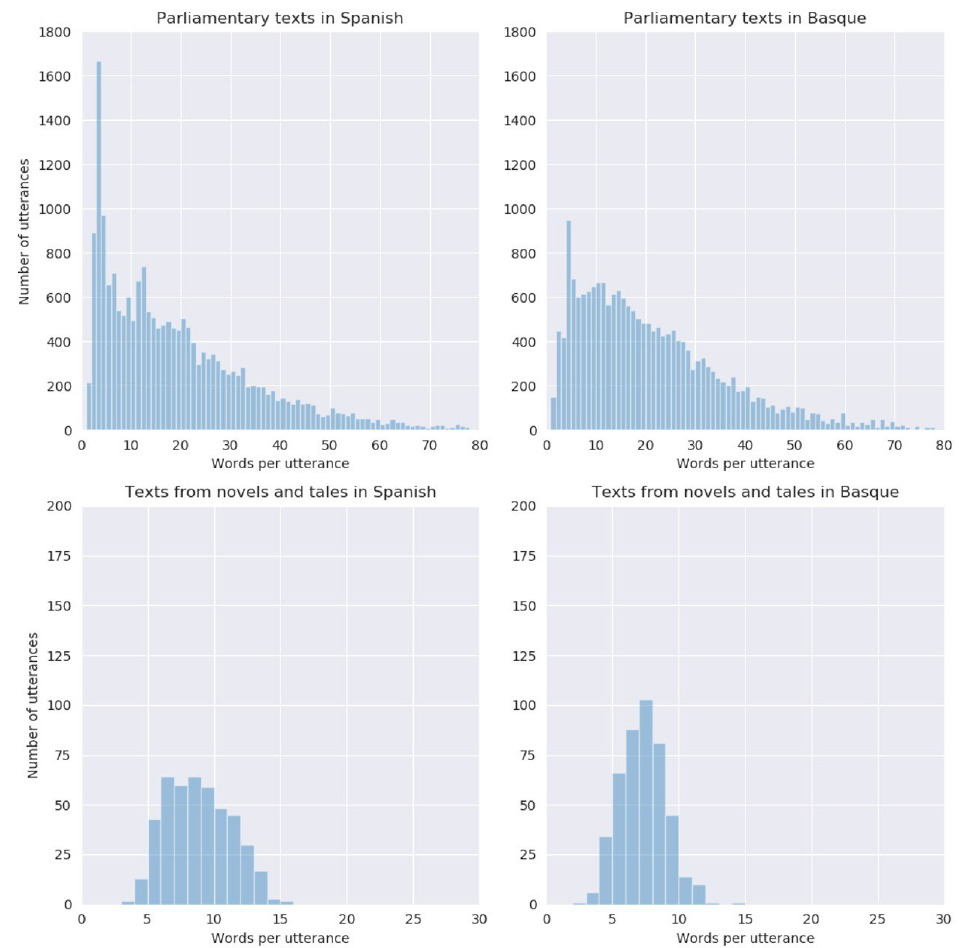
Figure 2. Distribution of words per utterance in the testing